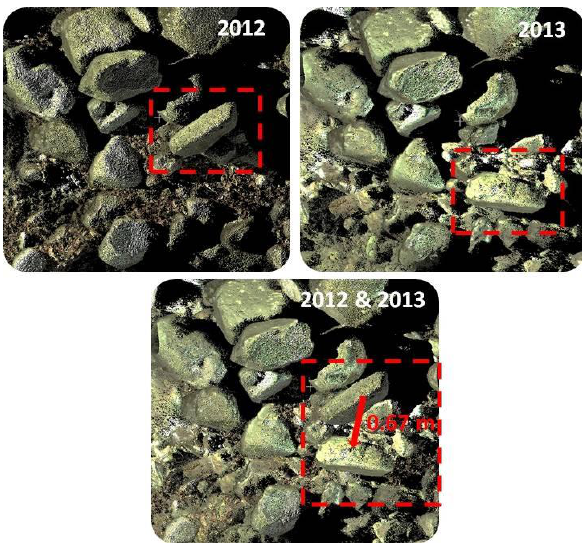
Figure 3. RGB point cloud combination and measurement